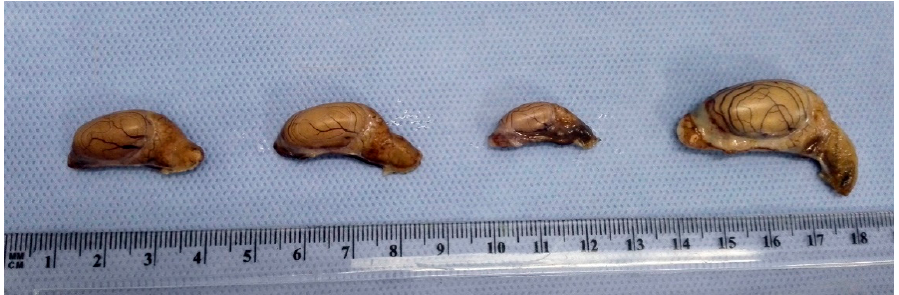
Figure 3. Testicles belonging to squirrels of different ages and breeding status.